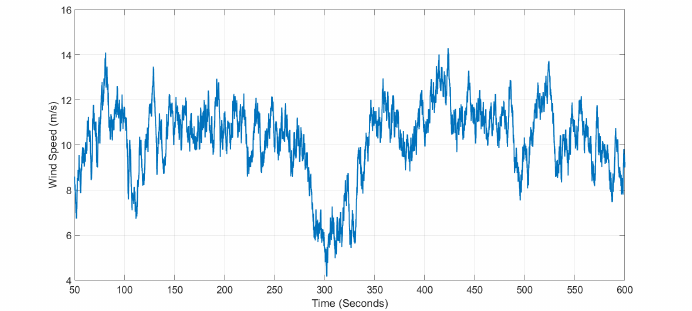
Figure 4. Aeroelastic model results for wind speed for a rated wind speed of 10 m/s.